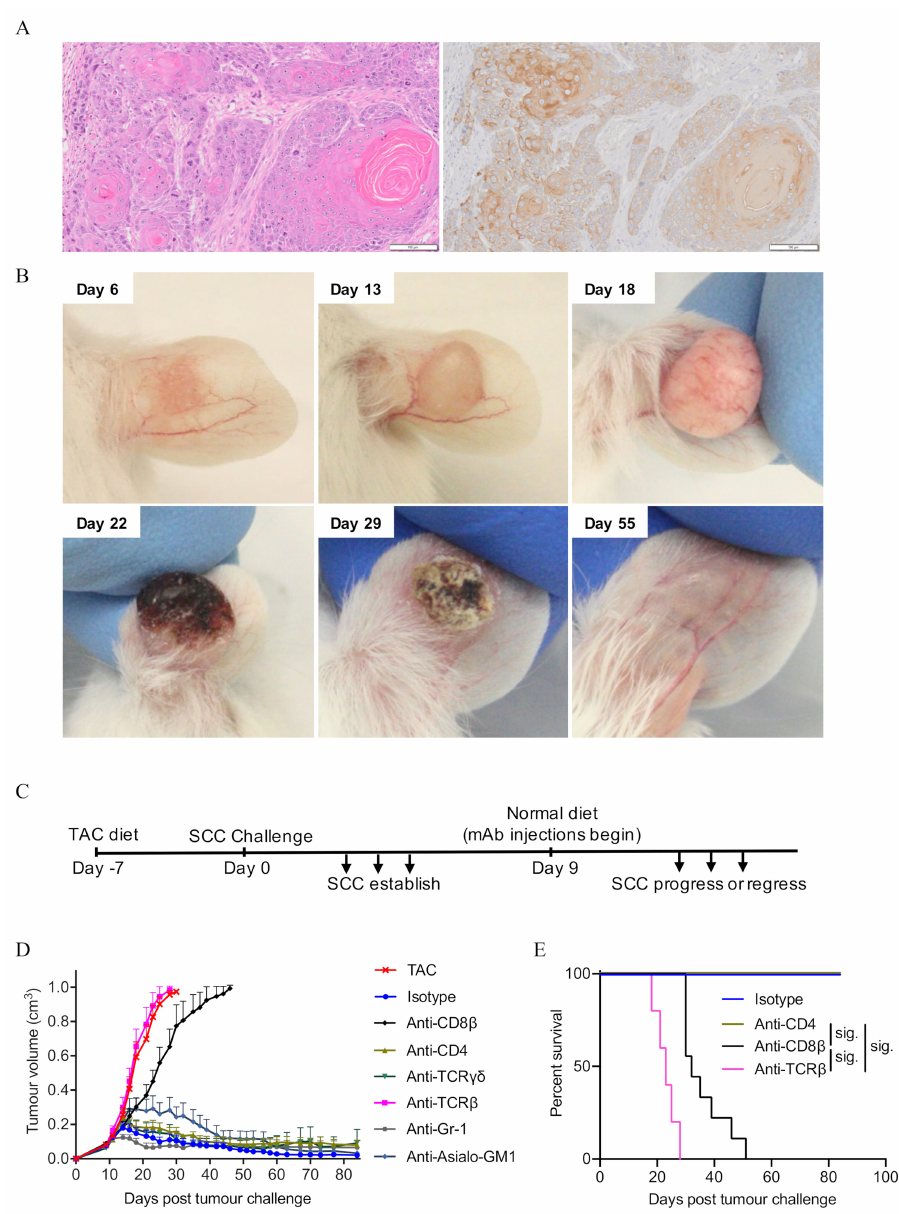
Figure 1. Depletion of immune subsets highlights a role for CD8 + T cells as mediators of SCC tumour regression. ( A ) Representative photomicrographs of SCC tumours growing in immunosuppressed mice. Left hand side: H&E; Right hand side: pan-cytokeratin. Scale bar = 100 µ m. ( B ) Example of established SCC regression following the removal of tacrolimus diet on day 13. Ear model used for illustrative purposes only. ( C ) Treatment schedule for SCC regression experiments. ( D ) SCC regression following depletion of immune subsets with the indicated antibodies. Combined data from 3 independent experiments (mean ± SEM) shown, n = 5–13/group. ( E ) Mouse survival in ( D